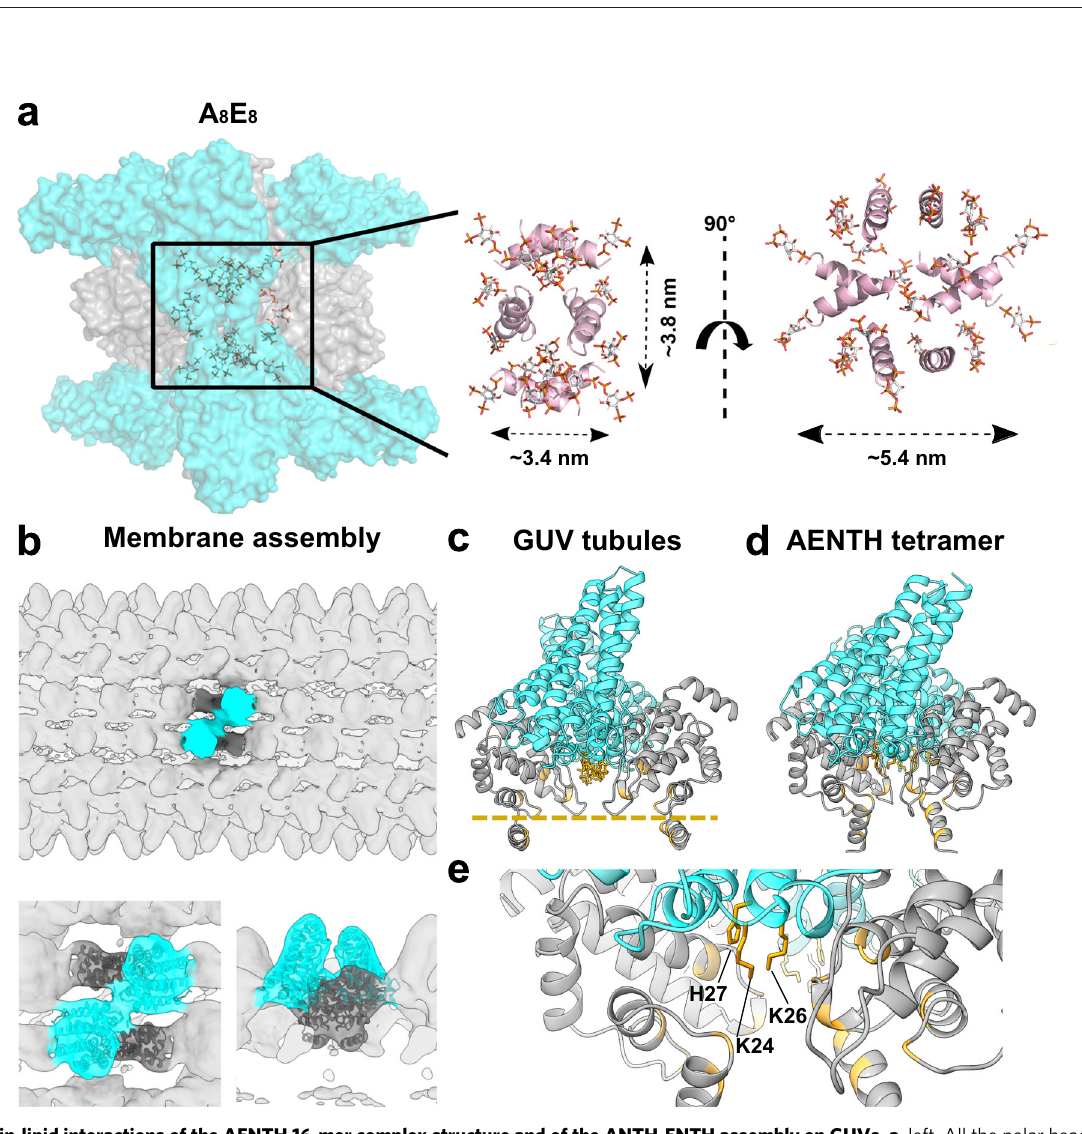
Fig. 4 Different interfaces present in the AENTH tetramer. a – c Schematic representation of the AENTH model showing the different interfaces present, designated as ANTH-ENTH interface 1 ( a ), ANTH-ENTH interface 2 ( b ), and ANTH-ANTH interface ( c ). In the lower panels, the residues involved in each of the interfaces are shown in stick representation and colored using the color scheme for each of the interfaces. ( d – f ) Intensity mass plot from DLS data showing the hydrodynamic radius of particles in solution for wild type AENTH (black) and different mutants. As a reference, the ANTH domain is shown in cyan (see Supplementary Table 1 for DLS parameters). d ANTH-ENTH interface 1 showing mutations ANTH Y100R (red) ANTH R25A (blue), ANTH R29A (green) and ENTH E107A (pink); ( e ) ANTH-ENTH interface 2 with mutations ANTH K10A/K13A/K14A (pink) ANTH K10D/K13D/K14D (yellow), ENTH E54A/D57A/D60A (blue) and ANTH Q9A/K10A (red). ( f ) ANTH-ANTH interface with mutations ANTH R3A (orange), ANTH R3A/I4A/D37R/H38A (blue), and ANTH R3A/I4A/D37R (red). g Summary of the native mass spectrometry results obtained for the mutants of the tetramer interfaces. h – j Growth defects of mutants of ANTH ( h ) and ENTH ( i ) ANTH-ENTH interface 1 and ANTH-ENTH interface 2. ( j ) Interface mutants were expressed after depletion or deletion of endogenous Ent1 and Sla2 proteins, respectively. Cell growth was analyzed after plating a 10-fold serial dilution of cells on SD-Ura plates and incubation for 3 days at 37 °C.